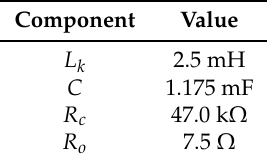
Table 3. Experimental test-bench parameters.